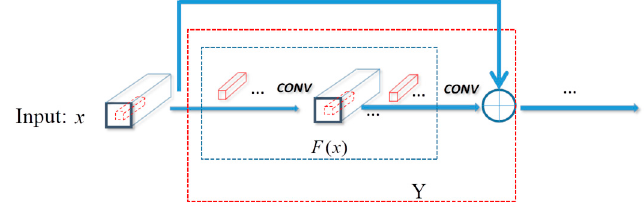
Figure 1. The structure of residual block.